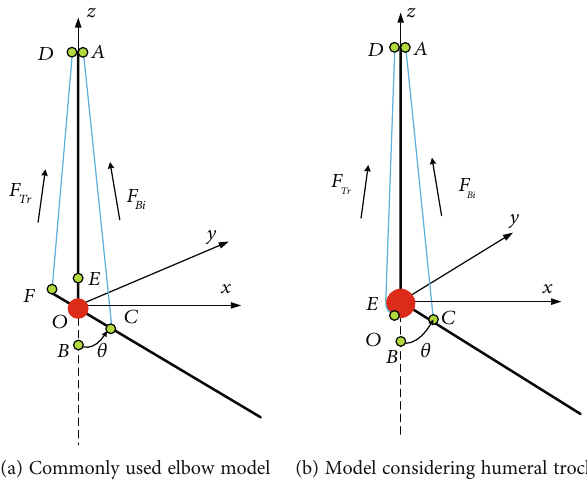
Figure 3: Comparison of elbow musculoskeletal